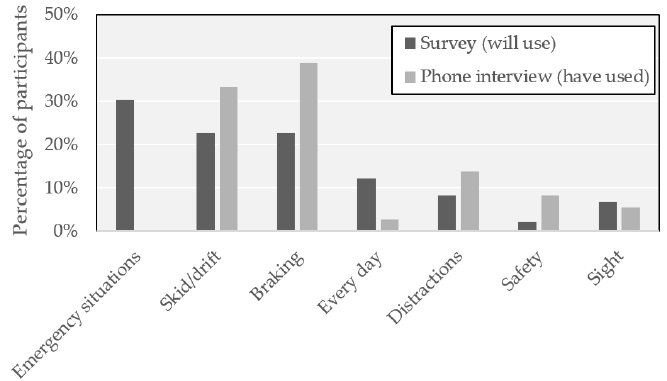
Figure 10. Topical areas for the use of skills learned: survey vs. phone interview.